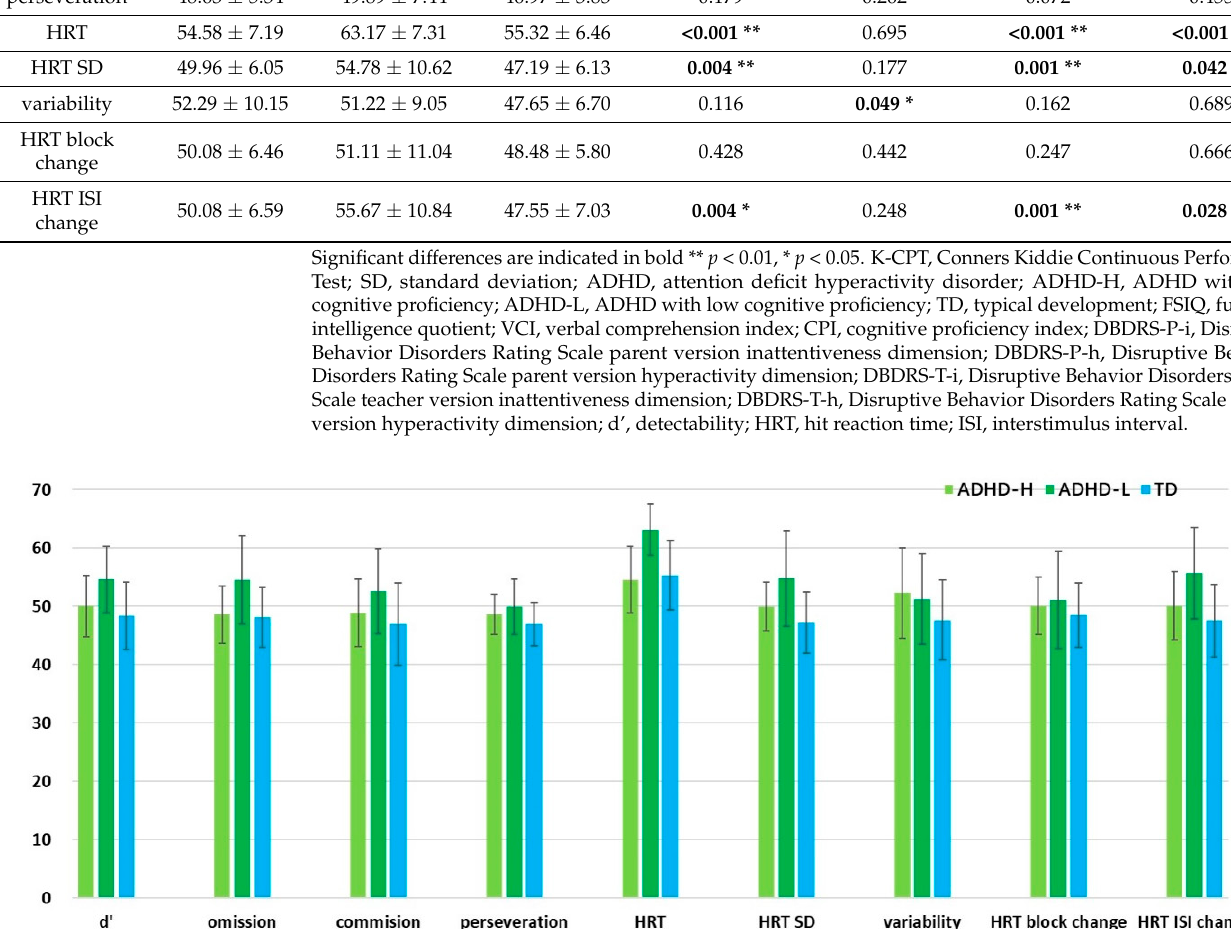
Resting relative spectral power did not differ between the groups (Supplementary